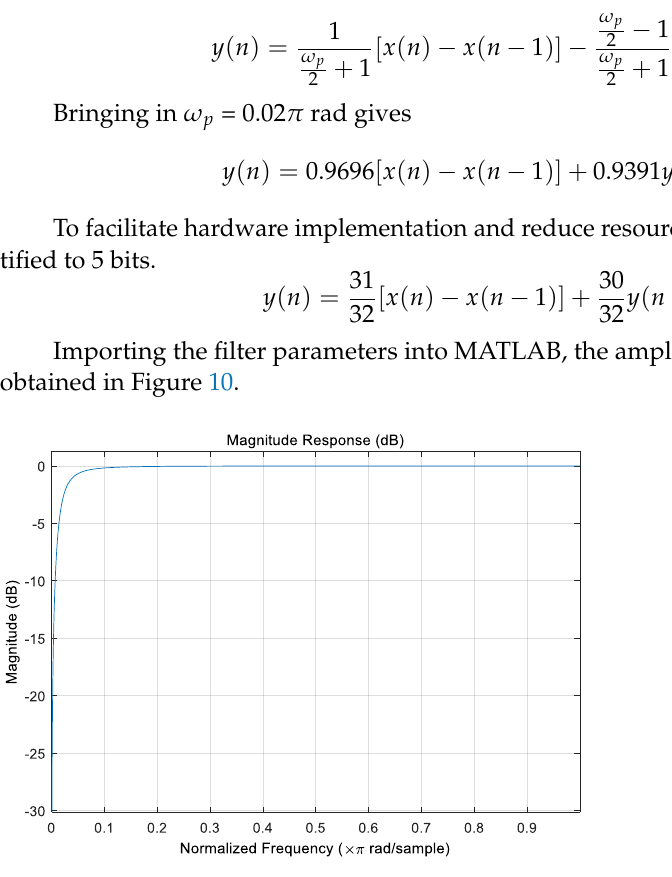
Figure 10. Amplitude and frequency response of the designed filter.